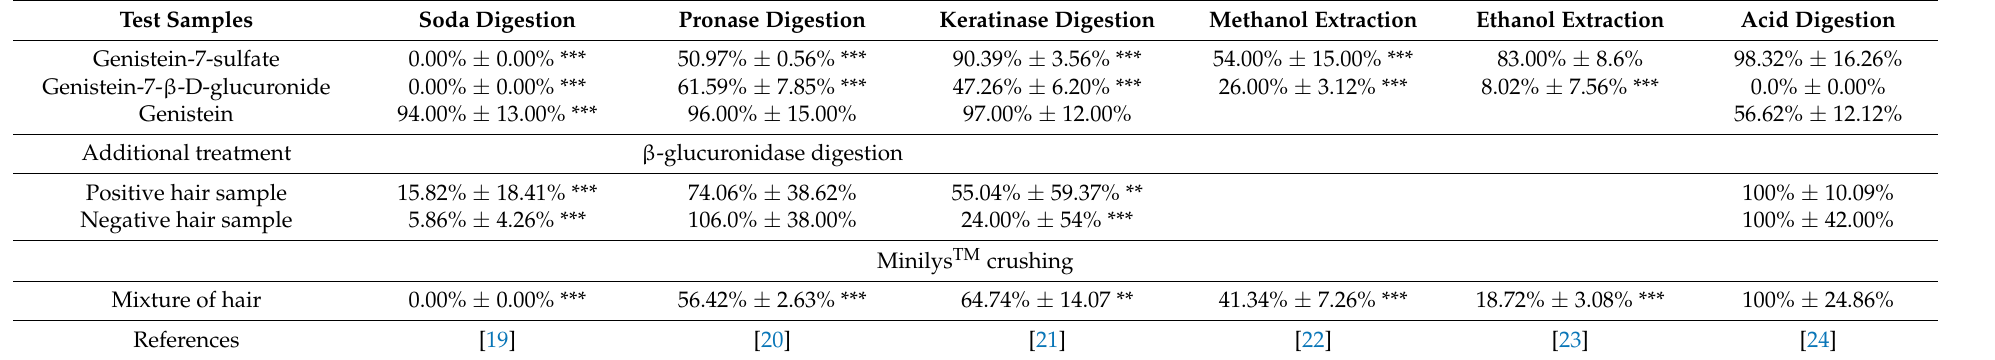
Table 2. Comparison of the GEN + DAI recovery following different digestion and extraction